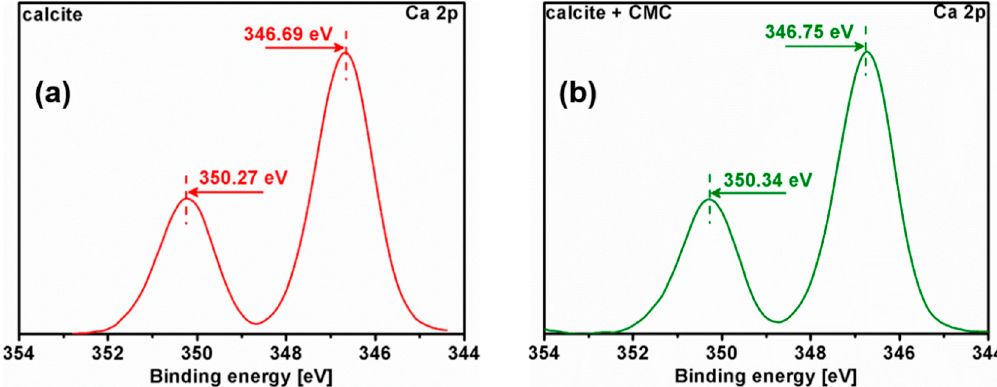
Figure 12. Ca 2p XPS spectra recorded from the surfaces of calcite in the absence ( a ) and presence ( b ) of CMC.